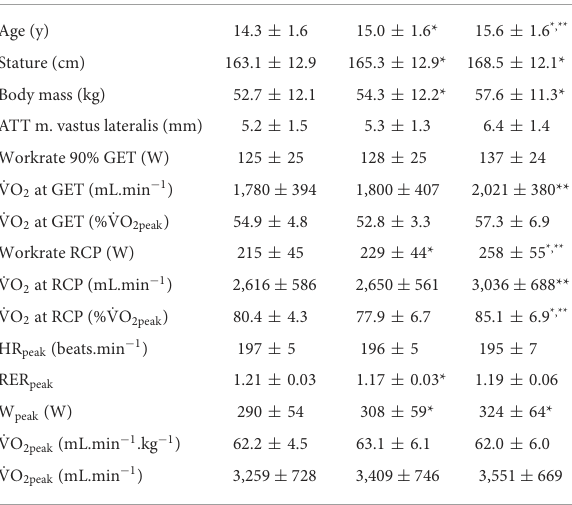
TABLE 1 Participants characteristics and results of the graded ramp exercise test as mean ± SD ( n =